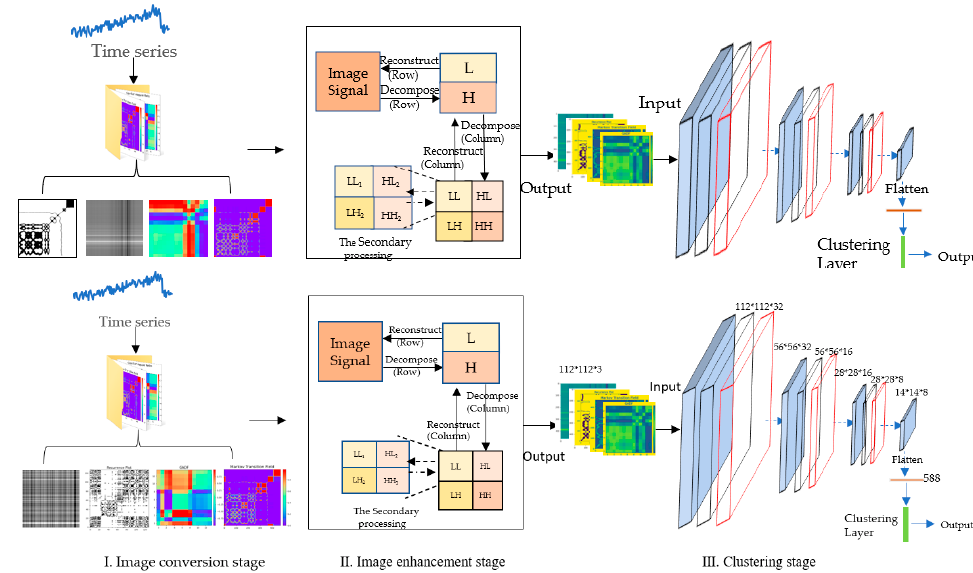
Figure 1. The frame of the GW-DC model.